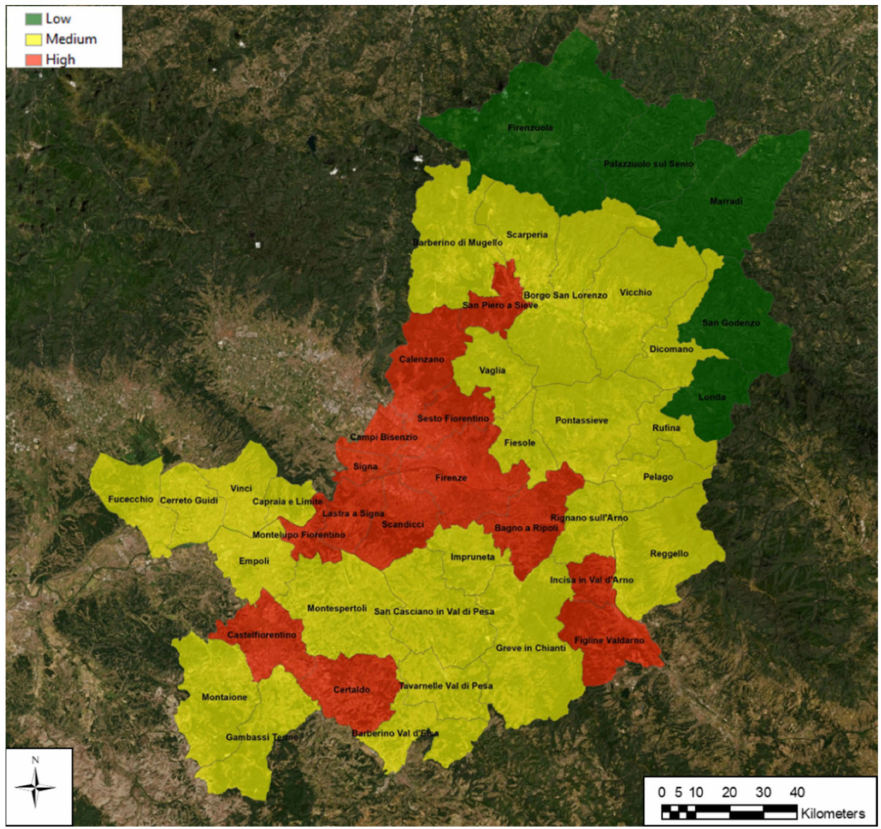
Figure 8. The thematic map of the number of inhabitants in residential buildings using the initial fuzzy partition.